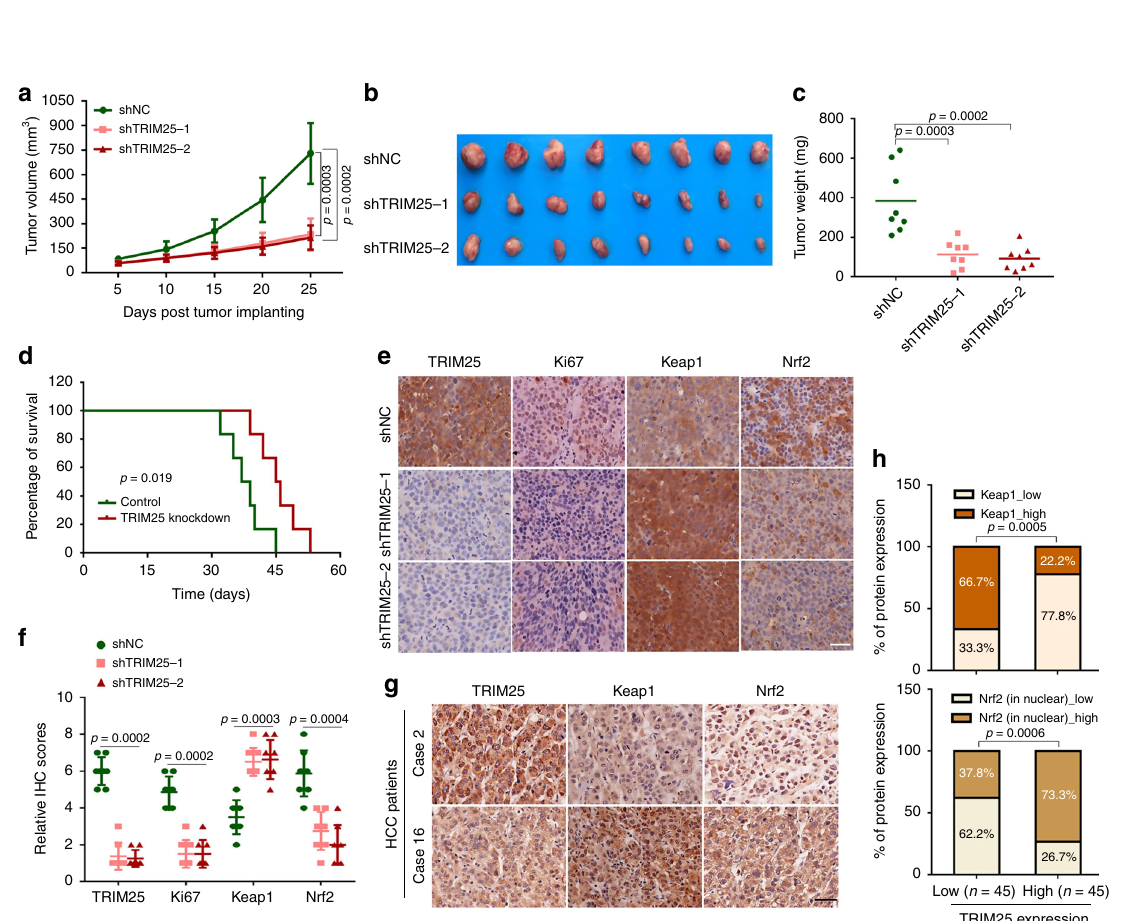
Fig. 6 Knockdown of TRIM25 in HCC suppresses tumor growth in nude mice. a – c Huh7 cells stably expressing the indicated shRNAs (shNC, shTRIM25-1 and shTRIM25-2) were subcutaneously injected in nude mice respectively. Shown are average tumor volumes over time ( n = 8) ( a ) and representative image ( b ) and weights ( c ) of tumors at day 25. d Kaplan – Meier analysis of overall survival percentage in nude mice inoculated with Huh7-shNC or Huh7- shTRIM25. The statistical signi fi cance was assessed using two-sided log-rank test according to mice with depletion of control or TRIM25. e , f Representative images ( e ) of IHC staining and the relative IHC scores ( n = 8) ( f ) of TRIM25, Ki67, Keap1 and Nrf2 in HCC tissues of mice inoculated with Huh7-shNC or Huh7-shTRIM25-1&-2. Scale bar, 50 μ m. g , h Representative IHC staining images ( g ) and statistical data ( h ) of TRIM25, Keap1 and Nrf2 expression in HCC tissues (TRIM25 low expression group, n = 45 and TRIM25 high expression group, n = 45). Scale bar, 50 μ m. For a , c , f , and h , data represent the mean ± SEM. Statistical signi fi cance was assessed using two-tailed Student ’ s t